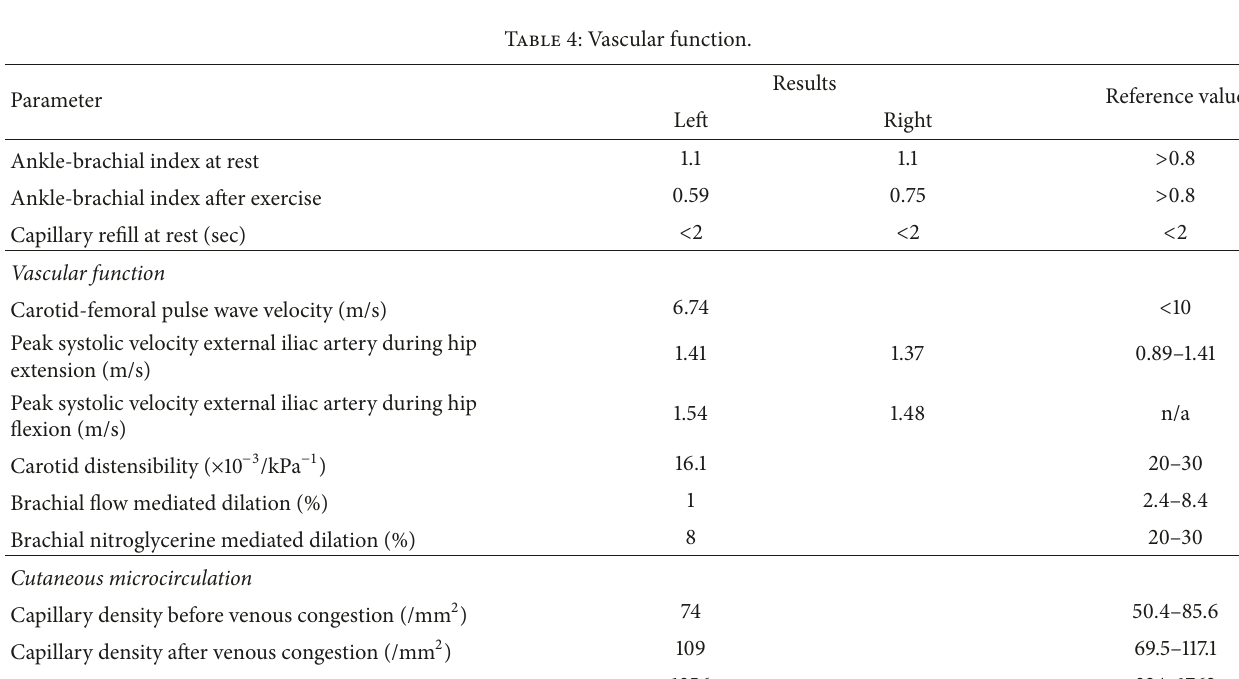
Table 4: Vascular